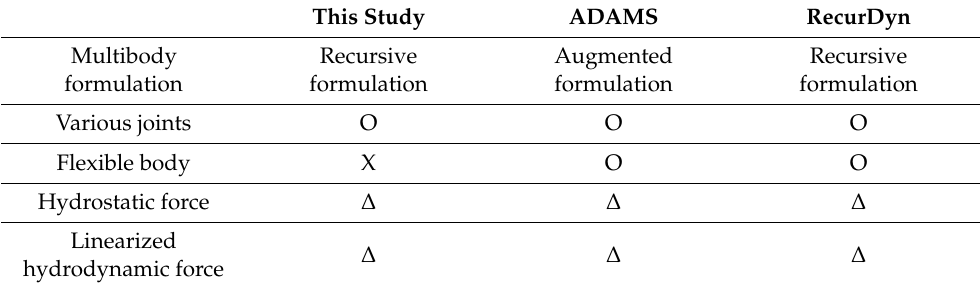
This Study ADAMS RecurDyn Recursive formulation